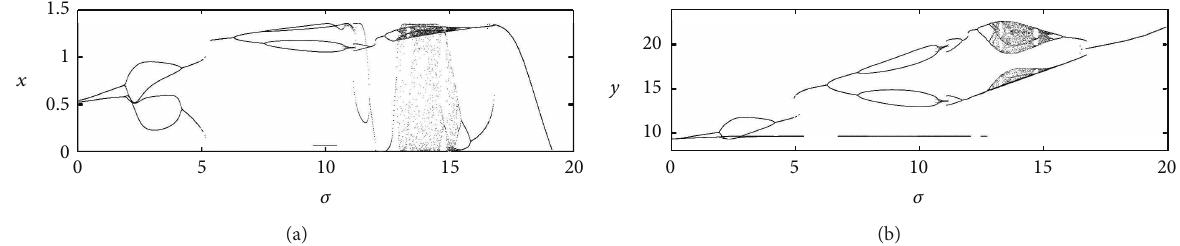
Figure 3: Bifurcation diagrams of model (24) with respect to bifurcation parameter 𝜎 . (a) Prey population 𝑥 with 𝜎 . (b) Predator population 𝑦 with 𝜎 . The other parameters are identical to those in Figure 2 and 𝑇 = 12